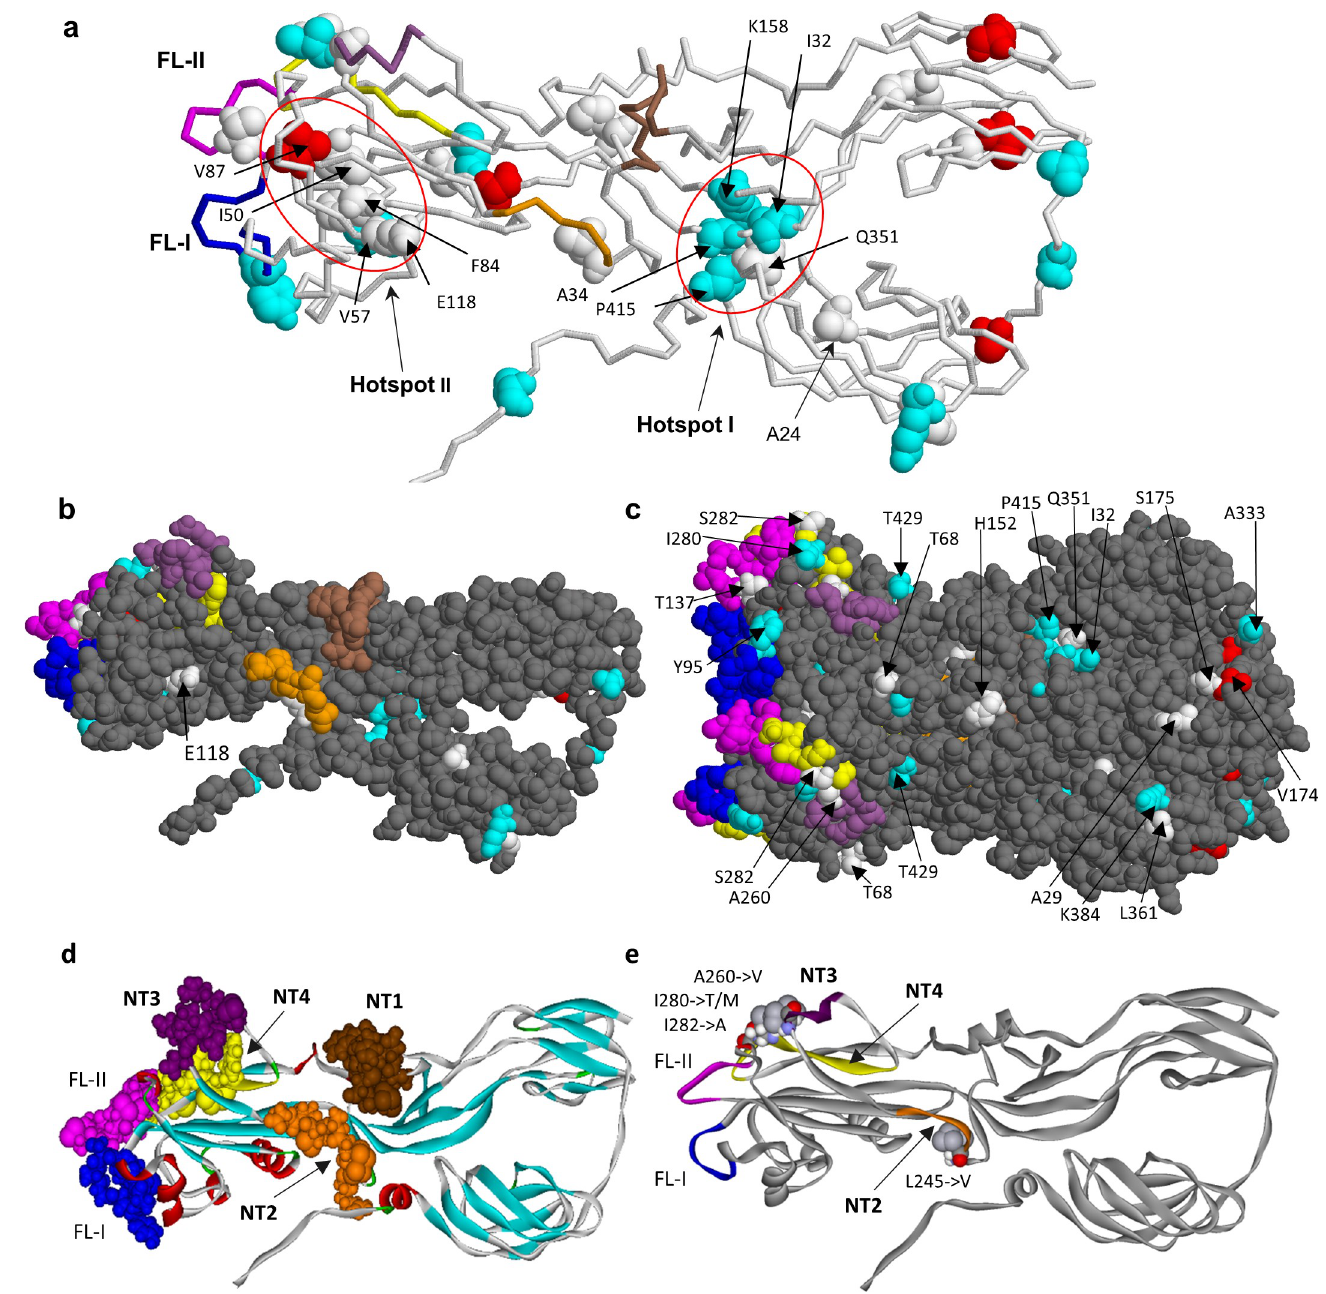
Fig 7. Location of amino acid substitutions in 3D structure of E1 glycoprotein. a. E1 monomer with all the identified substitutions mapped. The models of mutations were based on the coordinates from PDB entry 4adg. Mutational hotspots are shown encircled by a red line, the hotspot I including the residues I32, D34, K158, Q351, P415 and the hotspot II including the residues I50, V57, F84, V87, E118. The mutation A24- > V is common in all iVDRV strains studied. The mutation F84- > L was found in 5 of 6 strains and is located in the vicinity of the fusion loops. The color codes used: the variant residues found both in RVs and RVi (white spacefill), only in RVs (cyan spacefill), only in RVi (red spacefill); neutralizing epitopes NT1 (residues 225–235, brown), NT2 (245–251, orange), NT3 (260– 266, violet) and NT4 (274–285, yellow); fusion loops (FL-I, residues 89–98, blue; FL-II, residues 130–138, magenta). b, c. Mutated amino acid residues on the surface of E1 monomer ( b ) and trimer ( c ) in iVDRVs (solvent accessibility > 0.5, probe size 1.4A). d . The NT epitopes in E1 monomer. e . Possible escape mutations in the E1 neutralizing epitopes NT2, NT3 and NT4.